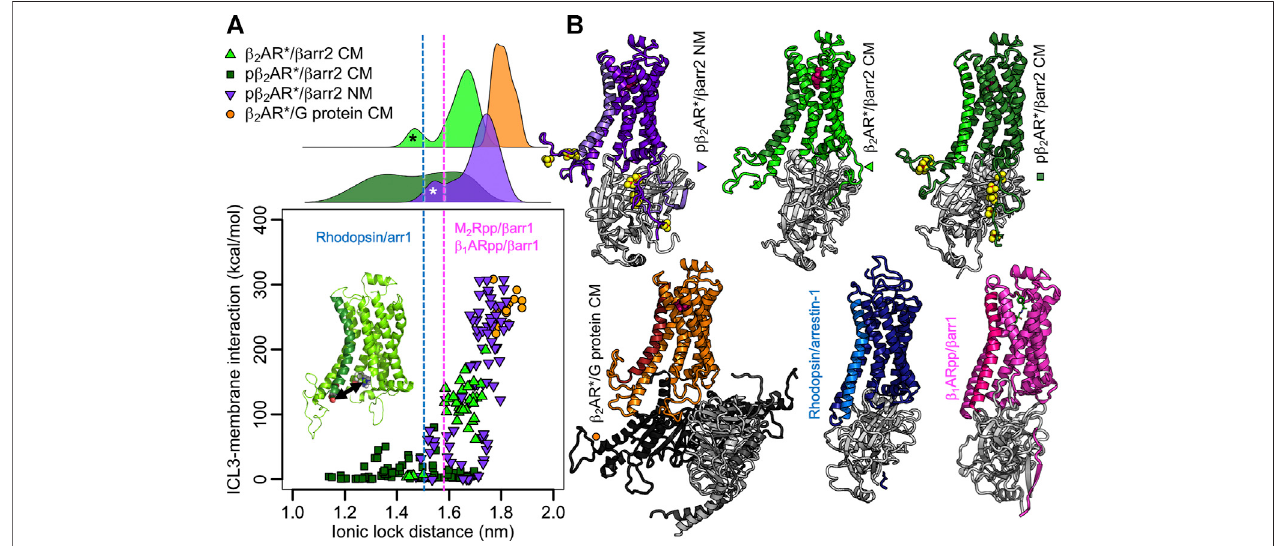
FIGURE 3 | ICL3-membrane binding in fl uences the extent of β 2 AR* activation. (A) Absolute interaction energies between the ICL3 of (p) β 2 AR* and the membrane plotted against the ionic lock distance (distance of C α atoms of Arg131 and Glu268, highlighted in the inset). Each data point equals an average over a 100-ns-interval. The fi rst 500 ns of each simulation were excluded for equilibration purposes. Data represents 5 β 2 AR*/ β arr2 CM simulations, 7 p β 2 AR*/ β arr2 CM simulations, 7 p β 2 AR*/ β arr2NMsimulations,3 β β β arr1(Leeetal.,2020), 2 AR*/GproteinCMsimulations.Theioniclockdistancesfromtherhodopsin/arrestin-1(Zhouetal.,2016), 1 ARpp/ andM 2 Rpp/ β arr1(Stausetal.,2020)structuresarehighlightedasblueandmagentadottedlines,respectively.Onthetop,thedistributionsoftheioniclockdistancesare shown. The peaks highlighted by asterisks point to simulations in which the ICL3 attached to arrestin instead to the membrane in one β 2 AR*/ β arr2 CM simulation (black asterisk)andtwop β 2 AR*/ β arr2NMsimulations(whiteasterisk).Thephosphategroupswereomittedintheinteractionenergycalculationtoobtaincomparablevaluesfor phosphorylated and nonphosphorylated receptors. (B) Representative structures of the complexes shown as cartoons. The receptor is color coded according to the simulation type, with TM6 highlighted in different color shades and the phosphates shown as yellow/red spheres. Arrestin is shown in light grey, G s protein in different shadesofgrey.Themembraneandsolventwereomittedfromthevisualizationforclarity.Thestructuresofthecomplexesofrhodopsinwitharrestin-1(Zhouetal.,2016) and β 1 ARpp/ β arr1 (Lee et al., 2020) are shown for